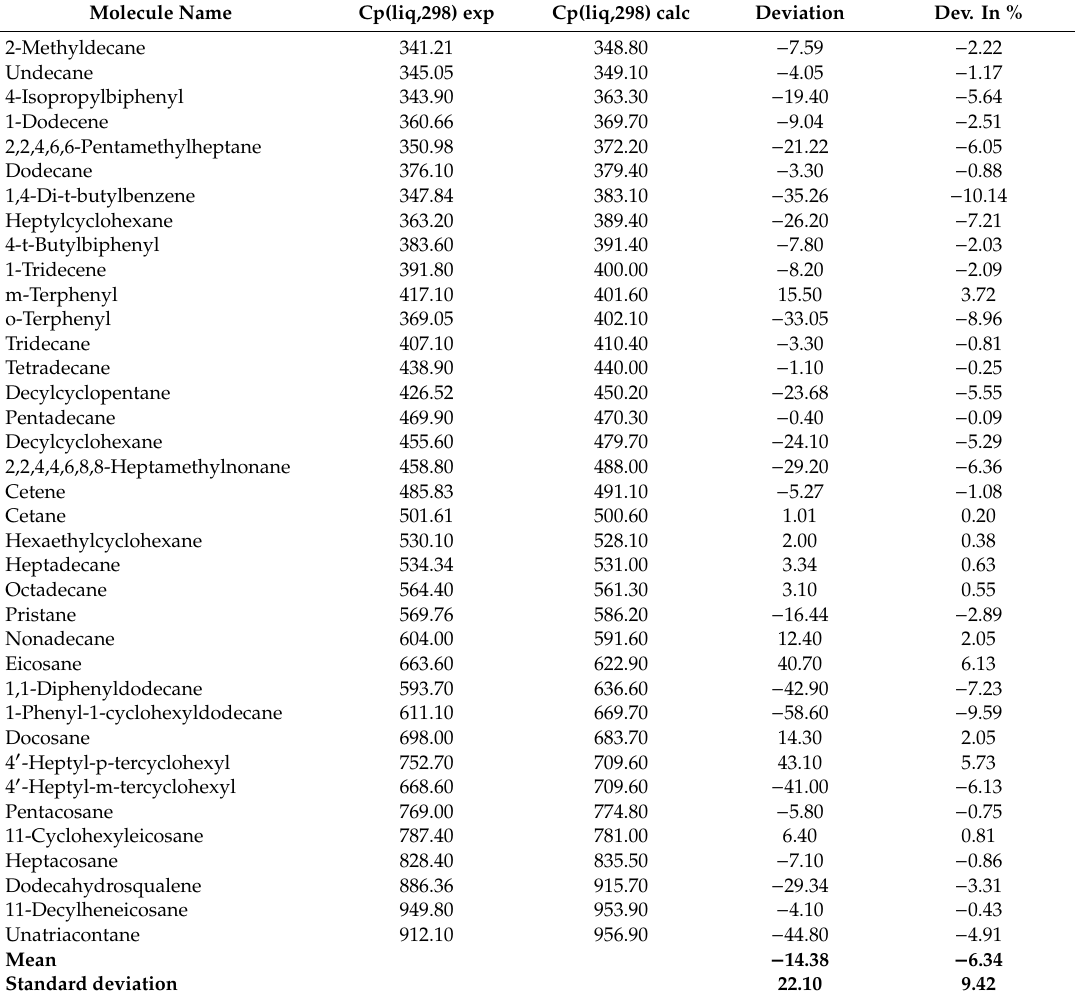
experimental inaccuracies, they indicate an important limitation of the present prediction method: the “true” molecular volume does not adequately reflect the decrease of the rotational degrees of freedom within the cyclic moiety of a molecule in relation to a ring-open one, although the volume of a cyclic structure is necessarily smaller than a non-cyclic one with the same number of carbon atoms due to the deduction of the partial volume of two hydrogen atoms per cycle which, however, only corresponds to a di ff erence of 17–23 J / mol / K per cycle between cyclic and non-cyclic alkanes, depending on the molecule